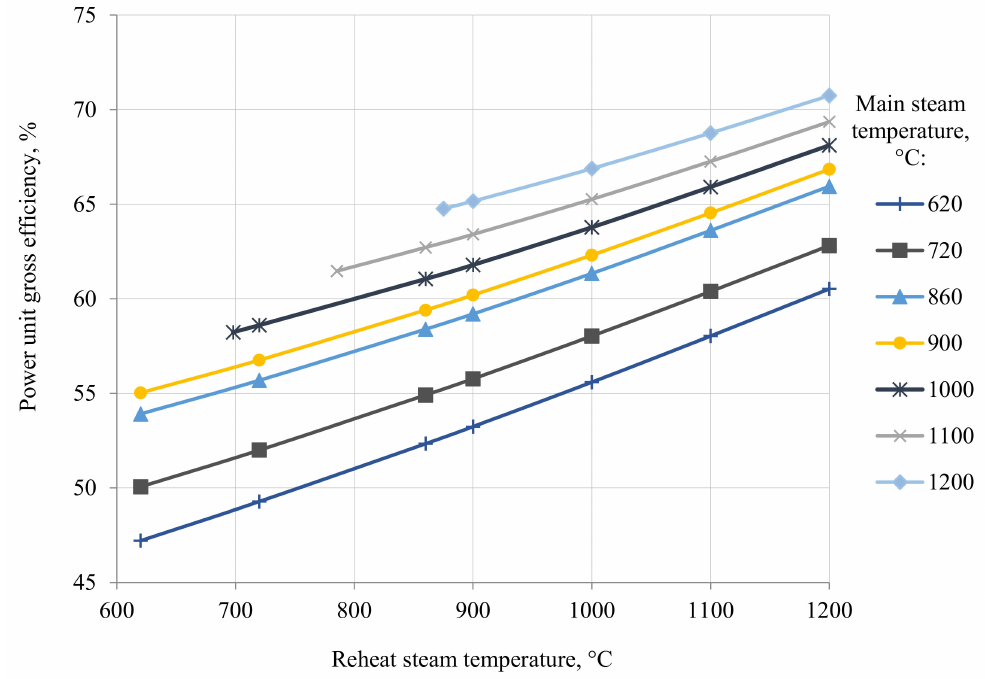
Figure 8. Efficiency of a hybrid power facility with two hydrogen